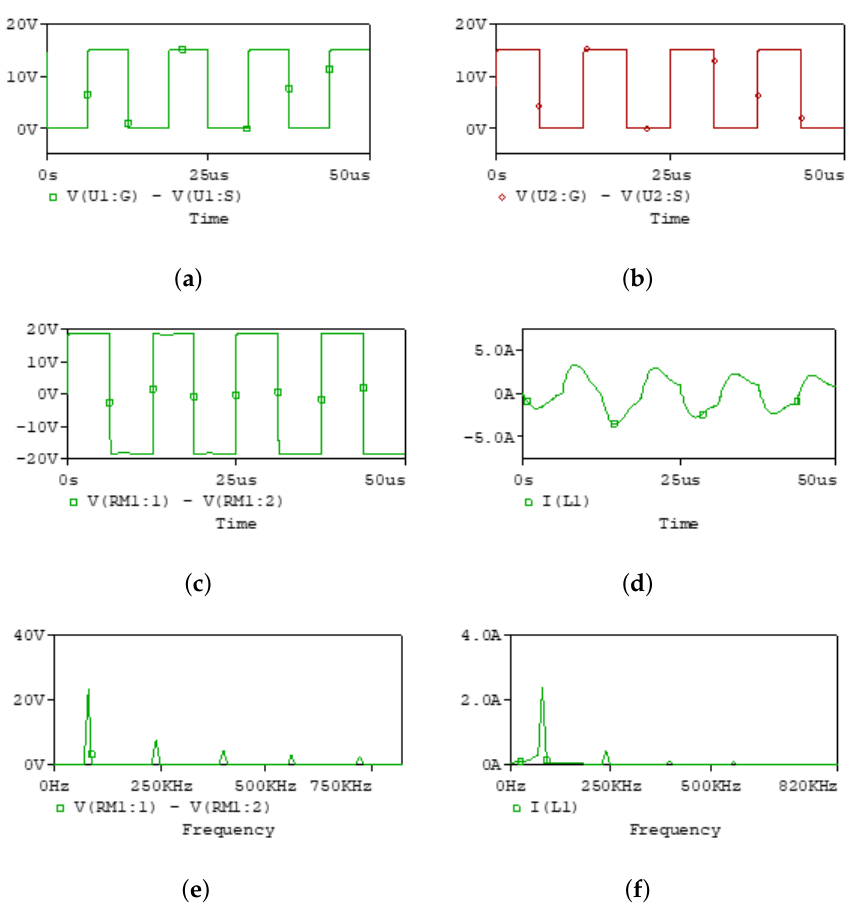
Figure 6. Simulation result. ( a ) Waveform at the gate of U 1 ; ( b ) waveform at the gate of U 2 ; ( c ) waveform of the output voltage; ( d ) waveform of the output current; ( e ) FFT spectrum analysis of ( c ); ( f ) FFT spectrum analysis of ( d